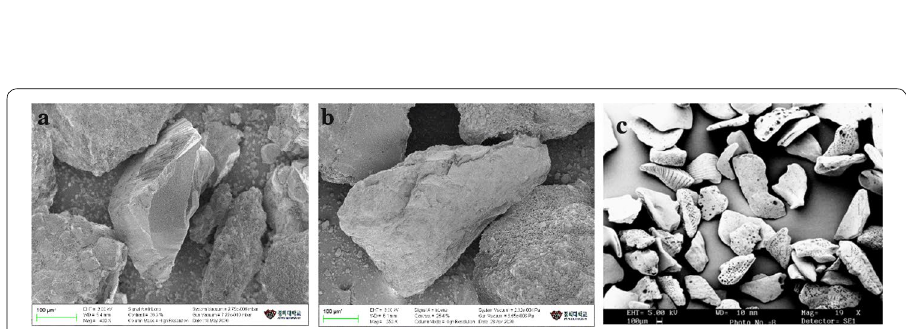
Fig. 8 The Scanning electron microscope (SEM) images of calcareous sands: a The Dissa Calcareous sand; b the Matmata calcareous sand; c Dog’s Bay carbonate sand (SEM image from Bowman et al.